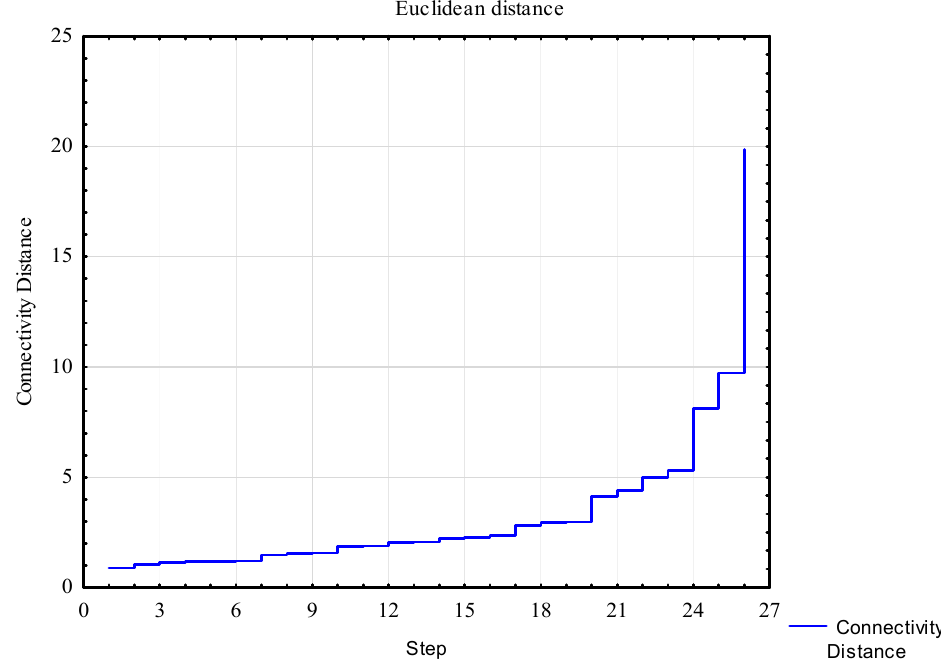
Figure 2. Diagram of the course of agglomeration for 2012. Source: author’s own study. On this basis, four clusters of varying size were identified in 2012. The connection tree for 2012 is shown in Figure 3.